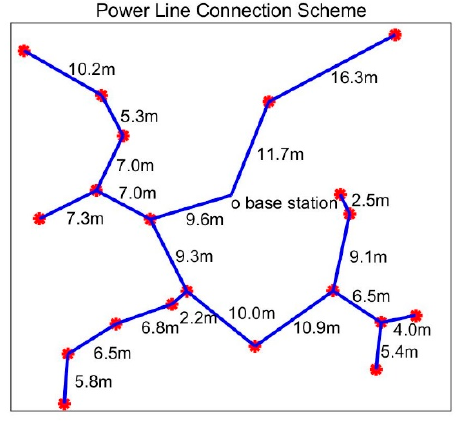
Figure 5. Power line connection scheme.